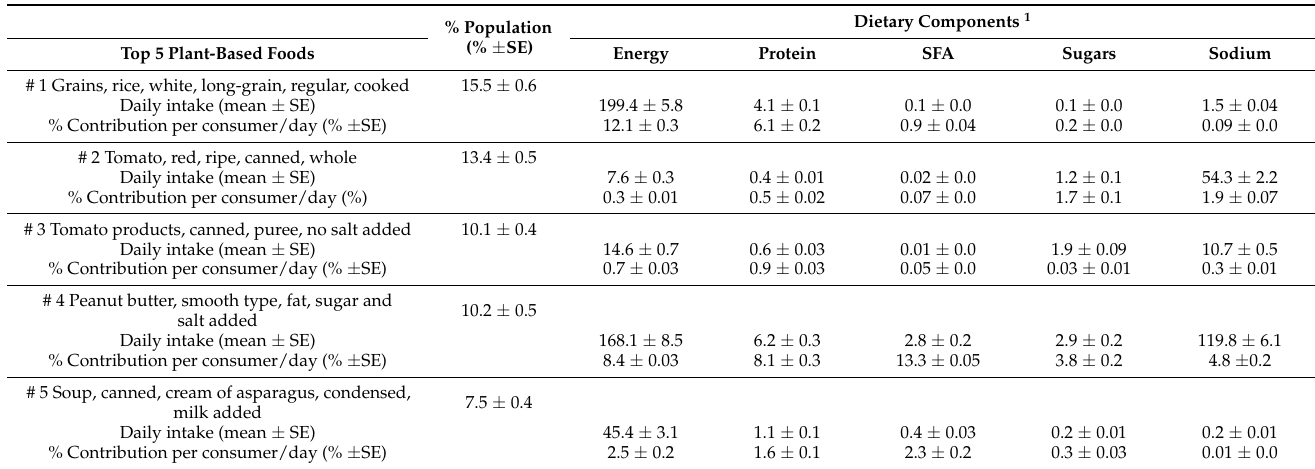
Table 5. The mean and percentage contribution of the top five reported plant-based foods to nutrients- to-limit, energy, and protein intake of Canadians aged ≥ 1 year in Canada, 2015 Canadian Community Health